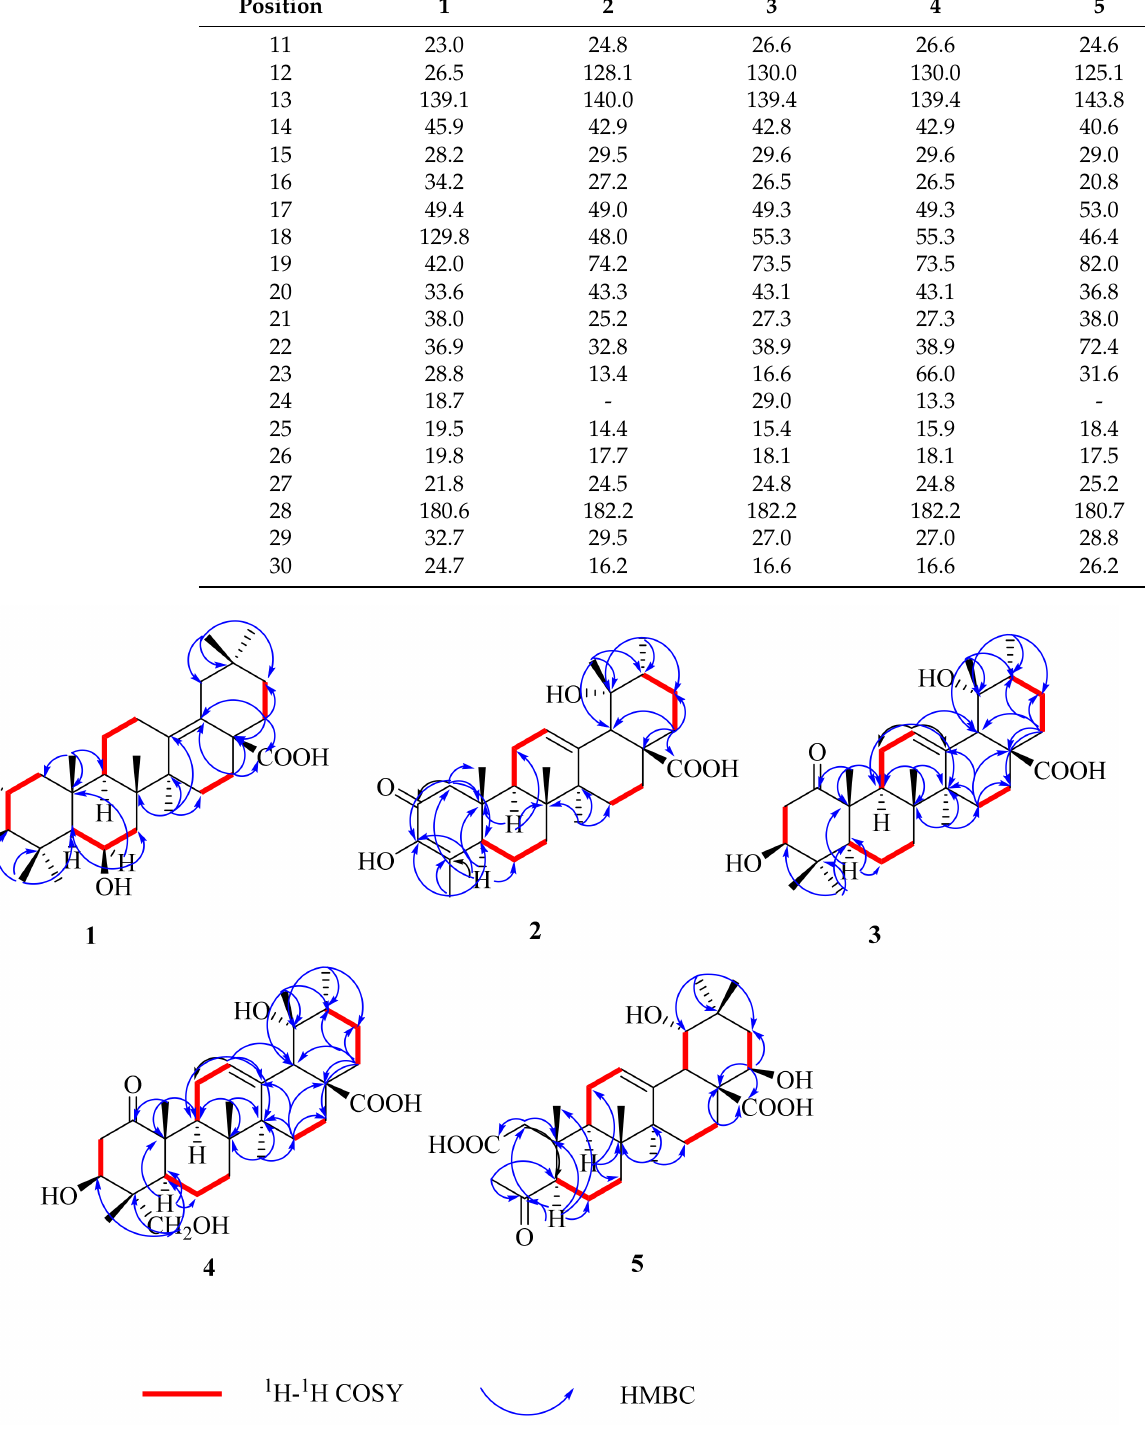
Figure 2. Key 1 H- 1 H COSY and HMBC correlations of compounds 1 – 5